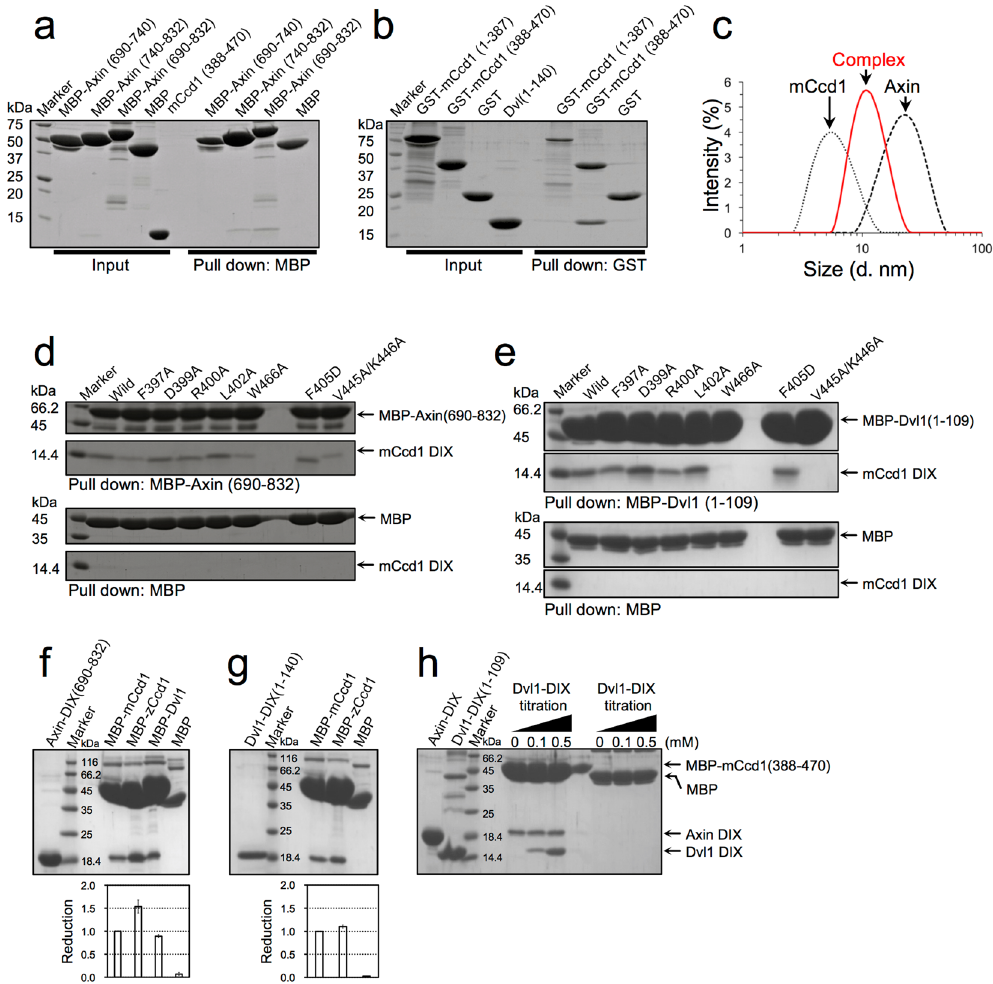
Figure 5. Heteromeric DIX-DIX interactions between mCcd1, Axin, and Dvl. ( a ) Pull-down assay of mCcd1 with MBP-fused Axin fragments. ( b ) Pull-down assay of Dvl1 with GST-fused mCcd1 fragments. ( c ) Apparent molecular size of the heteromeric complex (red line) formed between DIX domains of mCcd1 (dotted line) and Axin (dashed line) at the concentration of 100 μ M. ( d , e ) Pull-down assay of mCcd1 (wild type and mutants) with MBP-fused Axin ( d ) and Dvl1 ( e ) (The full-length gel images are available in supplementary information Fig. S6). ( f ) Pull-down assay of the MBP-fused mCcd1, zCcd1, and Dvl1 (0.8 mM) with Axin. ( g ) Pull-down assay of the MBP-fused mCcd1 and zCcd1 (0.8 mM) with Dvl1. ( h ) Effect of Dvl1 on Axin binding to Ccd1. The pull-down assay of the MBP-fused mCcd1 DIX domain with Axin DIX domain was performed without or with Dvl1 DIX at the indicated concentrations. Axin-mCcd1 binding was not influenced by